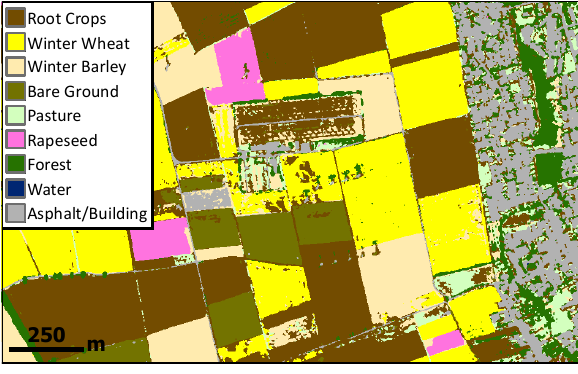
Figure 4. Subset of the MLC result of the WordView-2 scene.